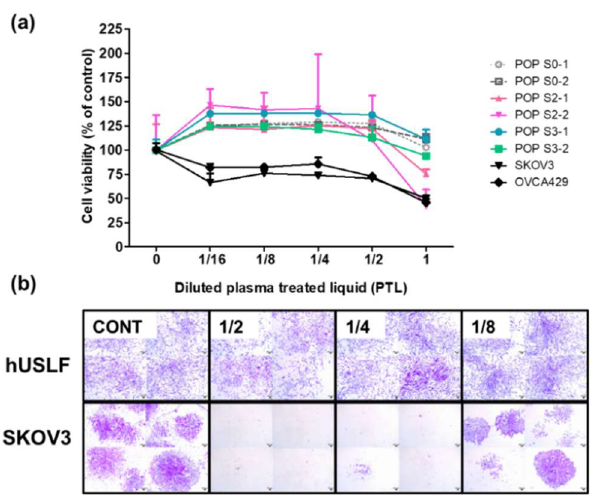
Figure 3. Cell viability of human uterosacral ligament fibroblasts (hUSLF) exposed to plasma-treated liquid ( a ). Cell viability was assessed under several conditions. A growth curve of the normal uterosacral ligament primary cells versus those of pelvic organ prolapse (POP) stage 0–1, stage 0–2, stage 2, stage 2–1, stage 2–2, stage 3, stage 3–1, and stage 3–2. SKOV3 and OVCA429 are ovarian cancer cell lines. ( b ) Colony-forming unit stain results are presented as proliferation changes. The differences between the crystal violet-stained cells were significant. Table 2. Cell viability (% of control).